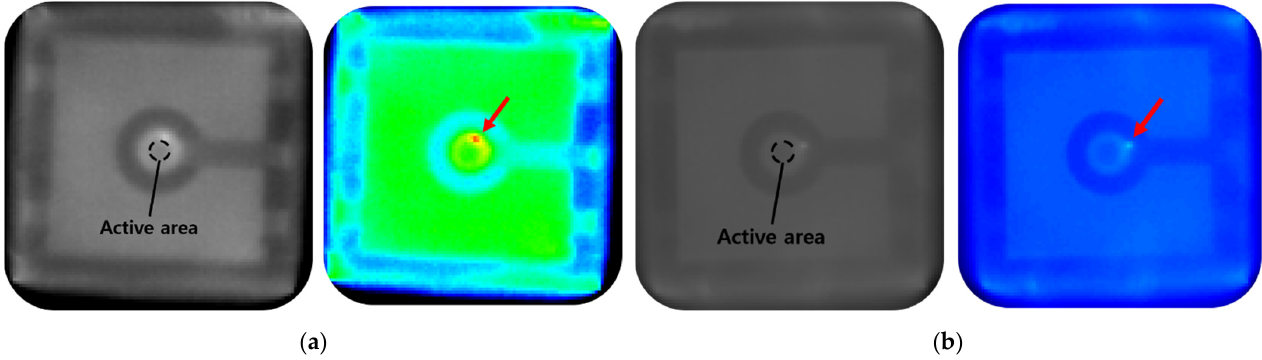
Figure 13. IR results of the failed APDs under the conditions of ( a ) 498 K with 500 μ A and ( b ) 498 K with 1000 μ A.